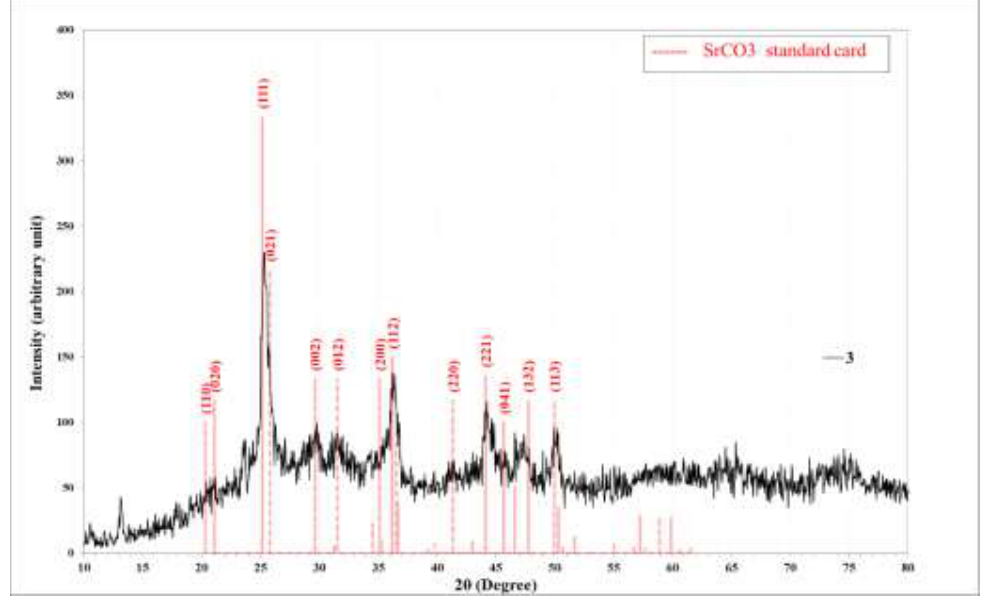
Fig.6: X-ray diffraction CNTs-Sr(OH)